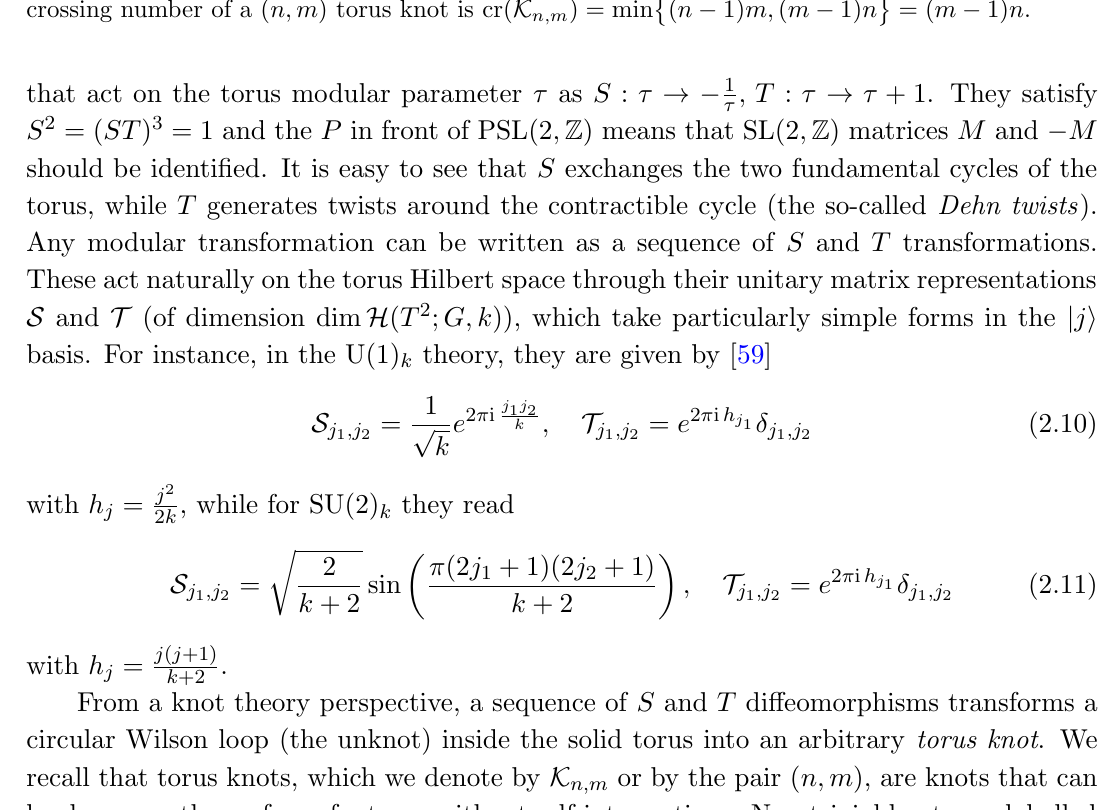
(cid:8) (cid:9) ( n (cid:0) 1) m; ( m (cid:0) 1) n = ( m (cid:0) 1) n